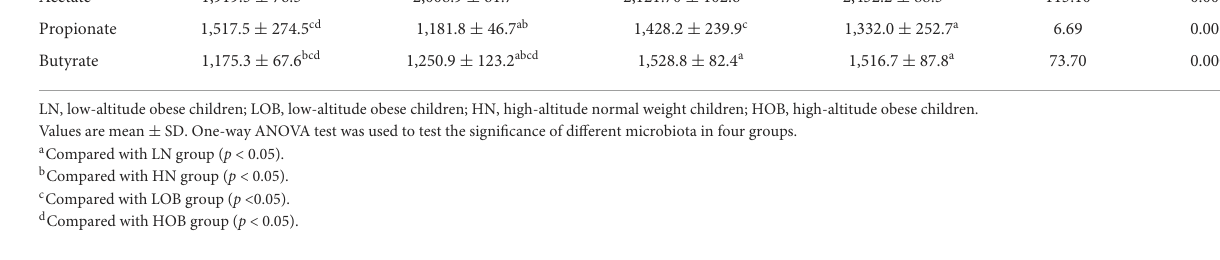
TABLE 6 Correlation between SCFAs and blood